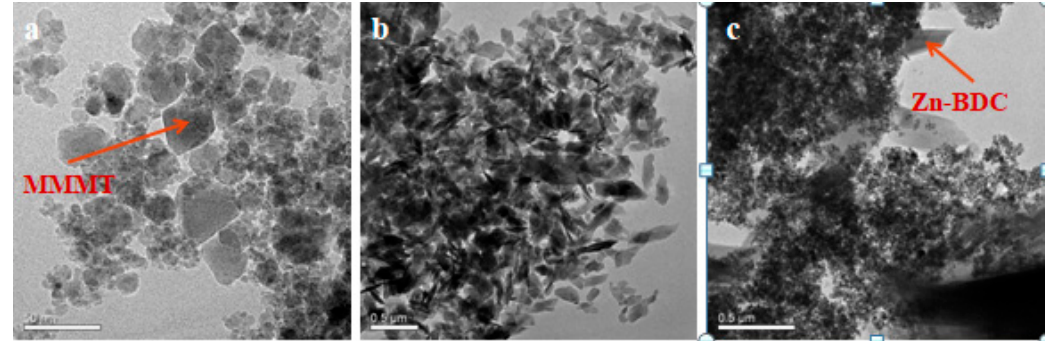
Figure 3. TEM of ( a ) MMMT, ( b ) Zn-BDC, and ( c ) MMMT@Zn-BDC.